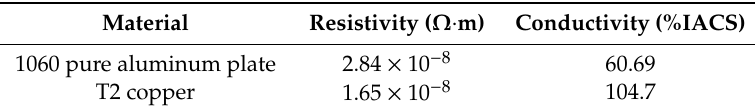
Table 8. Conductivity of base metal.